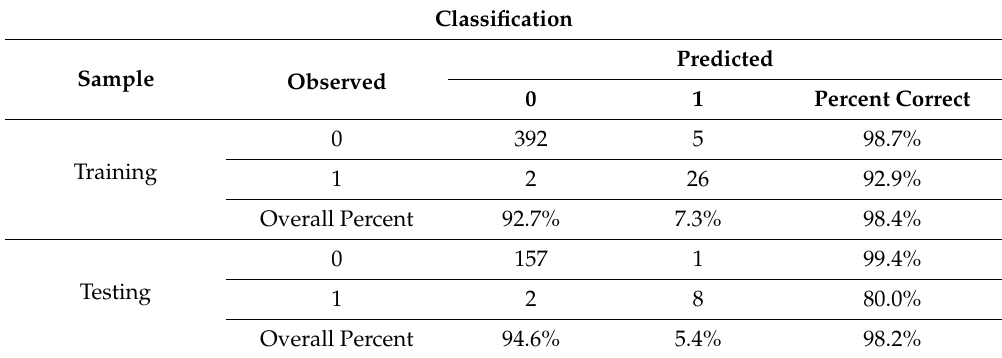
Table 4. Confusion matrix for multilayer perceptron for predicting e ffi ciency of recommending